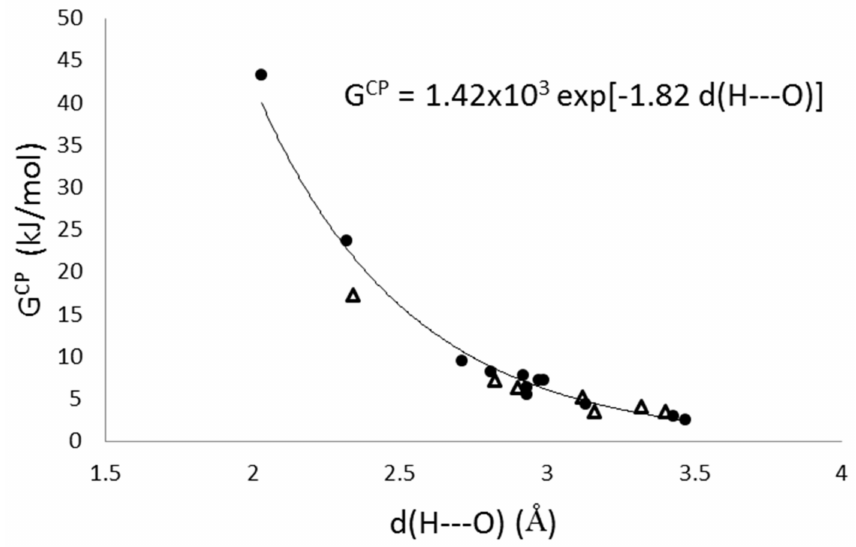
Figure 7. Behavior of G CP versus d(H—O). Black dots are for hydrogen bonds between MOF ´ s and guest molecules. Triangles are for hydrogen bonds between guest